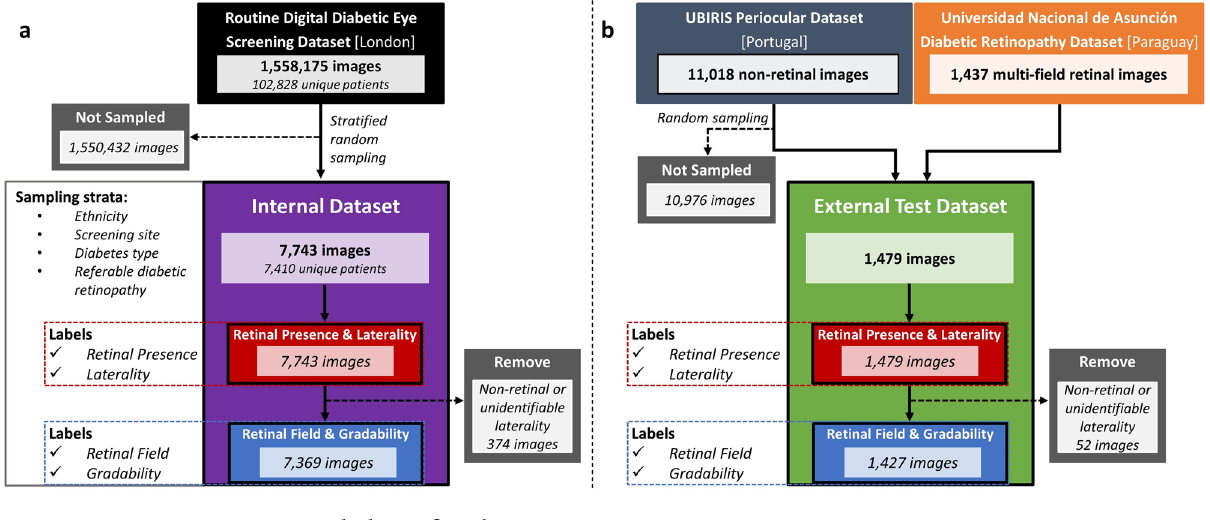
Figure 2. Study dataset flow